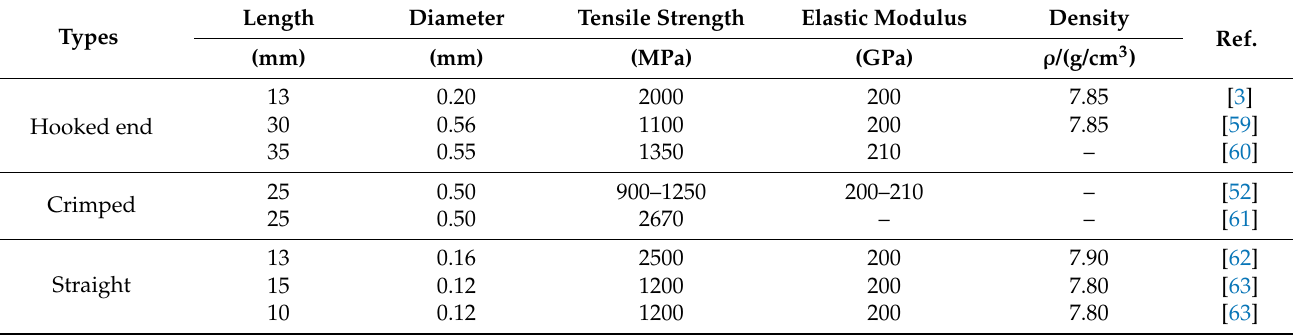
Table 2. Basic mechanical properties of steel fibers.